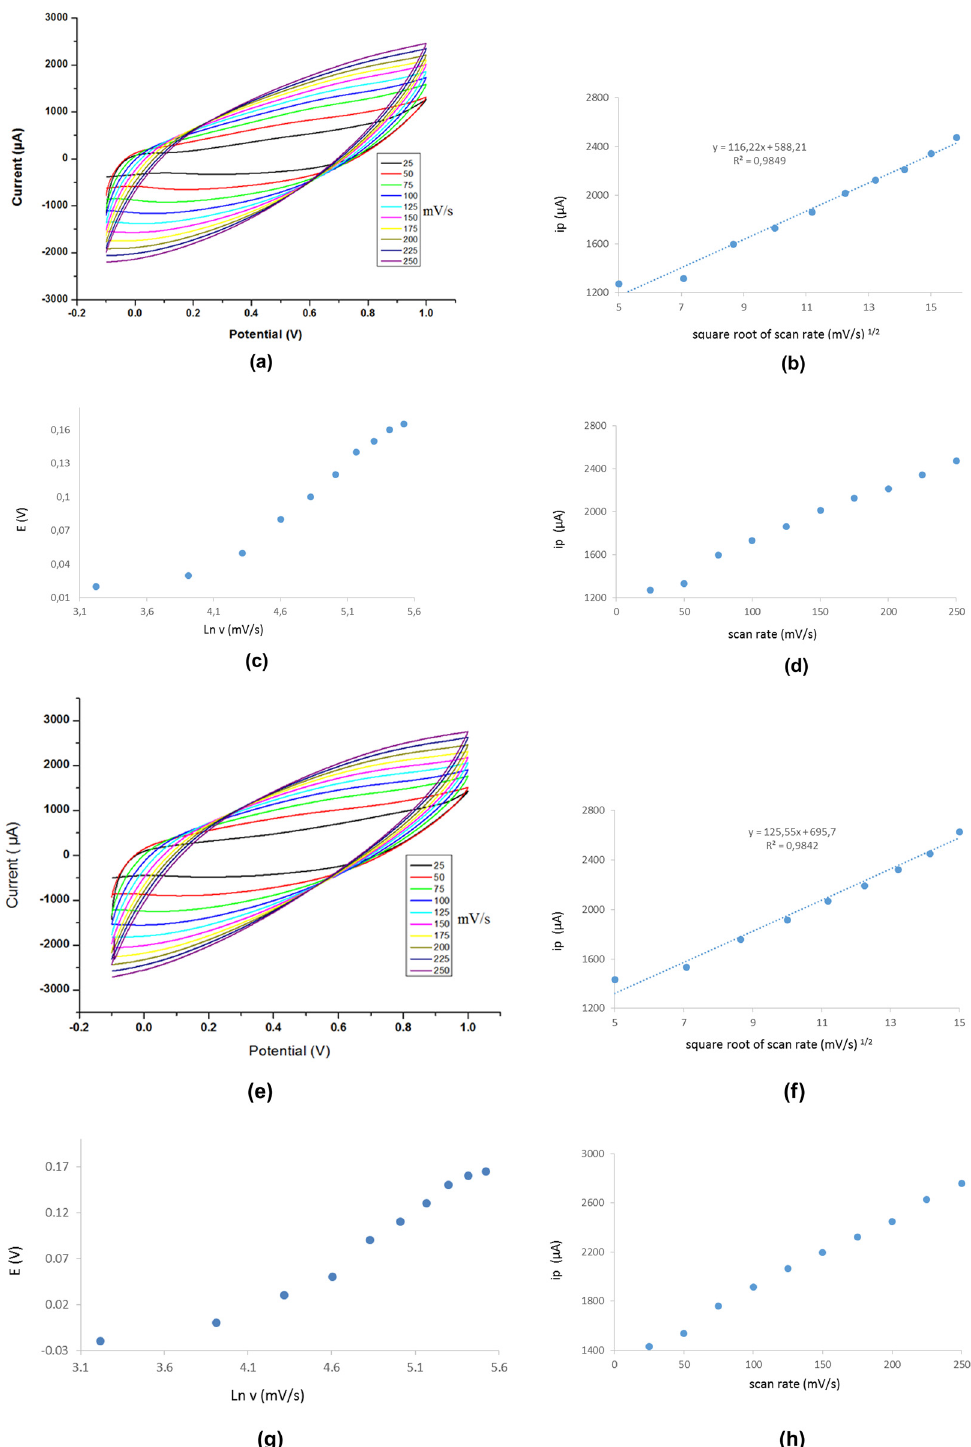
Figure 5: Cyclic voltammograms ( I – V ) , current versus square root of scan speed ( I − ν 1/2 ) , potential versus ln of scan rate ( E − ln ν ) and current versus scan rate ( I − ν ) of copolymer - modi fi ed ( a – d ) and enzyme immobilized copolymer - modi fi ed ( e – h ) GC electrodes with various scanning method according to the current values to be obtained at amounts of lactose addition as shown in Figure 6 [ 40 ] . + 0.12 V, in which lactose is oxidized against the known To determine the response of the enzyme - modi fi ed